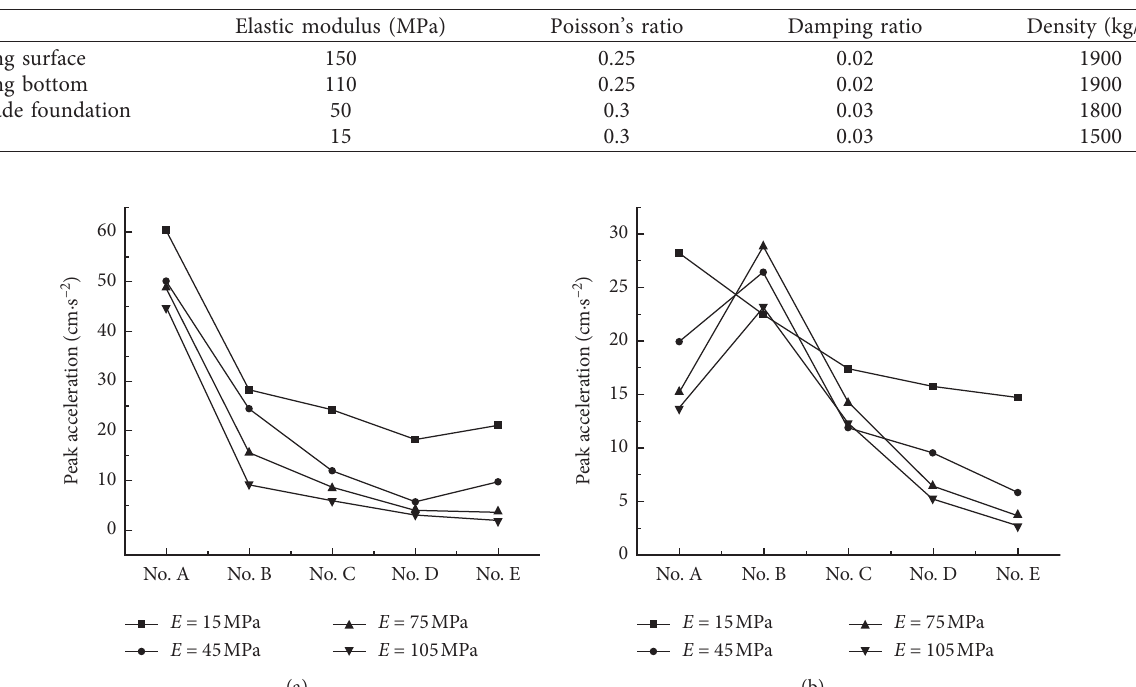
Figure 13: Influence of the elastic modulus of the foundation on peak acceleration. (a) Horizontal direction. (b) Vertical